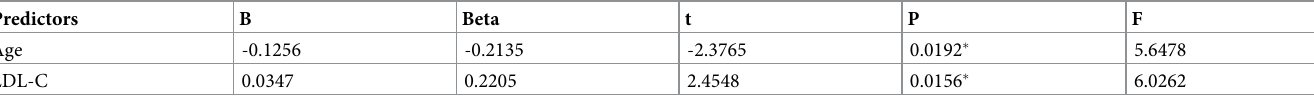
Table 4. Model 2. Multiple regression analysis to analyze the contribution of each predictor including LDL-C in predicting the %NC (n = 115).